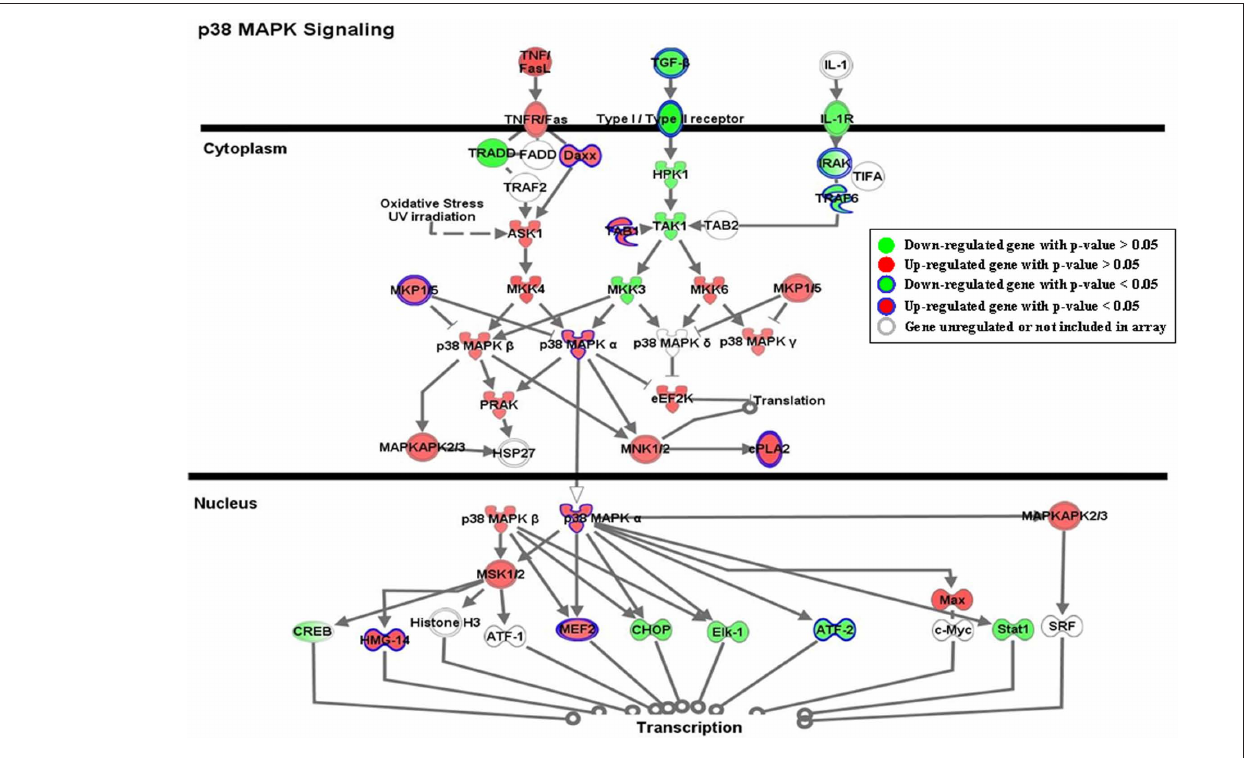
pattern of the pathway, all the genes with expression ratios >1.1 or <0.90 relative to the controls are also shown. The genes in white with light gray edges are either not regulated by nicotine (expression ratios between 0.9 and 1.1) or were not measured in our analysis. The pathway was drawn by the IPA